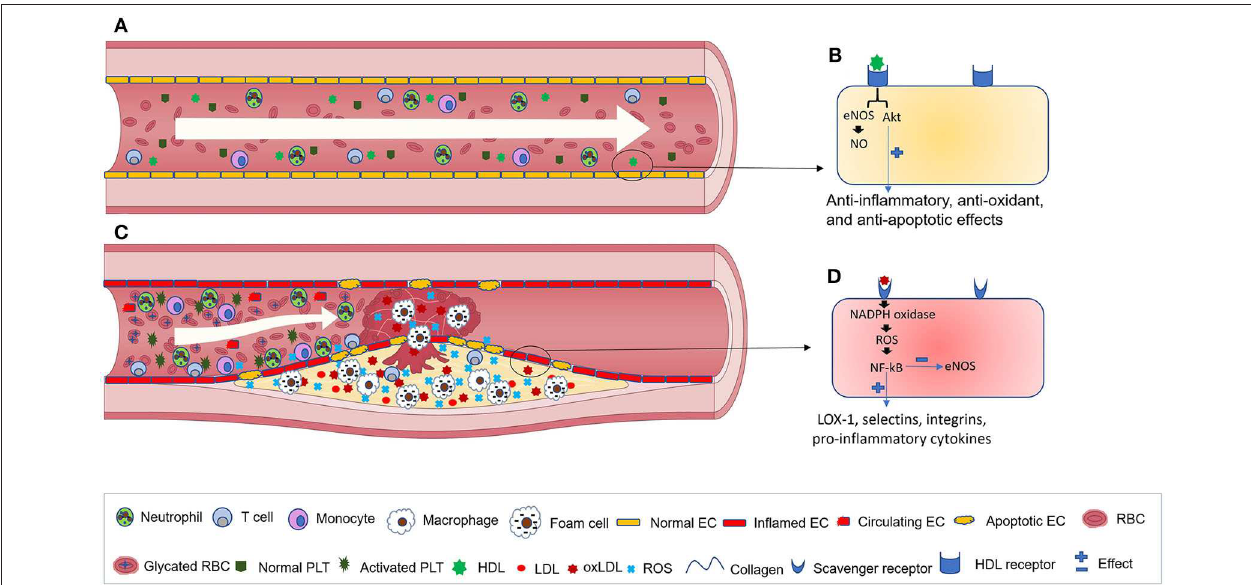
FIGURE 2 | Blood vessels in healthy individuals and T2DM patients. (A) normal blood flow in healthy individuals. (B) A close view of HDL binding to its receptors on the surface of ECs that results in the activation of anti-inflammatory cascades. (C) Blood vessels in T2DM patients. During the progression of the disease, red blood cells become glycated, while activated ECs synthesize elevated levels of adhesion molecules and chemokines that facilitate monocytes recruitment, adhesion, and transmigration across the endothelium toward the subendothelial region. Monocytes are then differentiated into macrophages and eventually, by excess lipid uptake, generate foam cells. Subsequently, further immune cell infiltration into the atherosclerotic lesion occurs, where their inflammatory cytokines promote platelet activation, EC apoptosis, and increased generation of ROS and Ox-LDL. (D) interactions between oxLDL and its receptor aggravate ROS generation, NF- κ B activation and inflammation. EC, endothelial cell; RBC, red blood cell; PLT, platelet; HDL, high-density lipoprotein; Ox-LDL, Oxidized low-density lipoprotein; ROS, reactive oxygen species; eNOS, endothelial nitric oxide synthase; NO, Nitric oxide; LOX-1, lectin-type oxidized LDL receptor